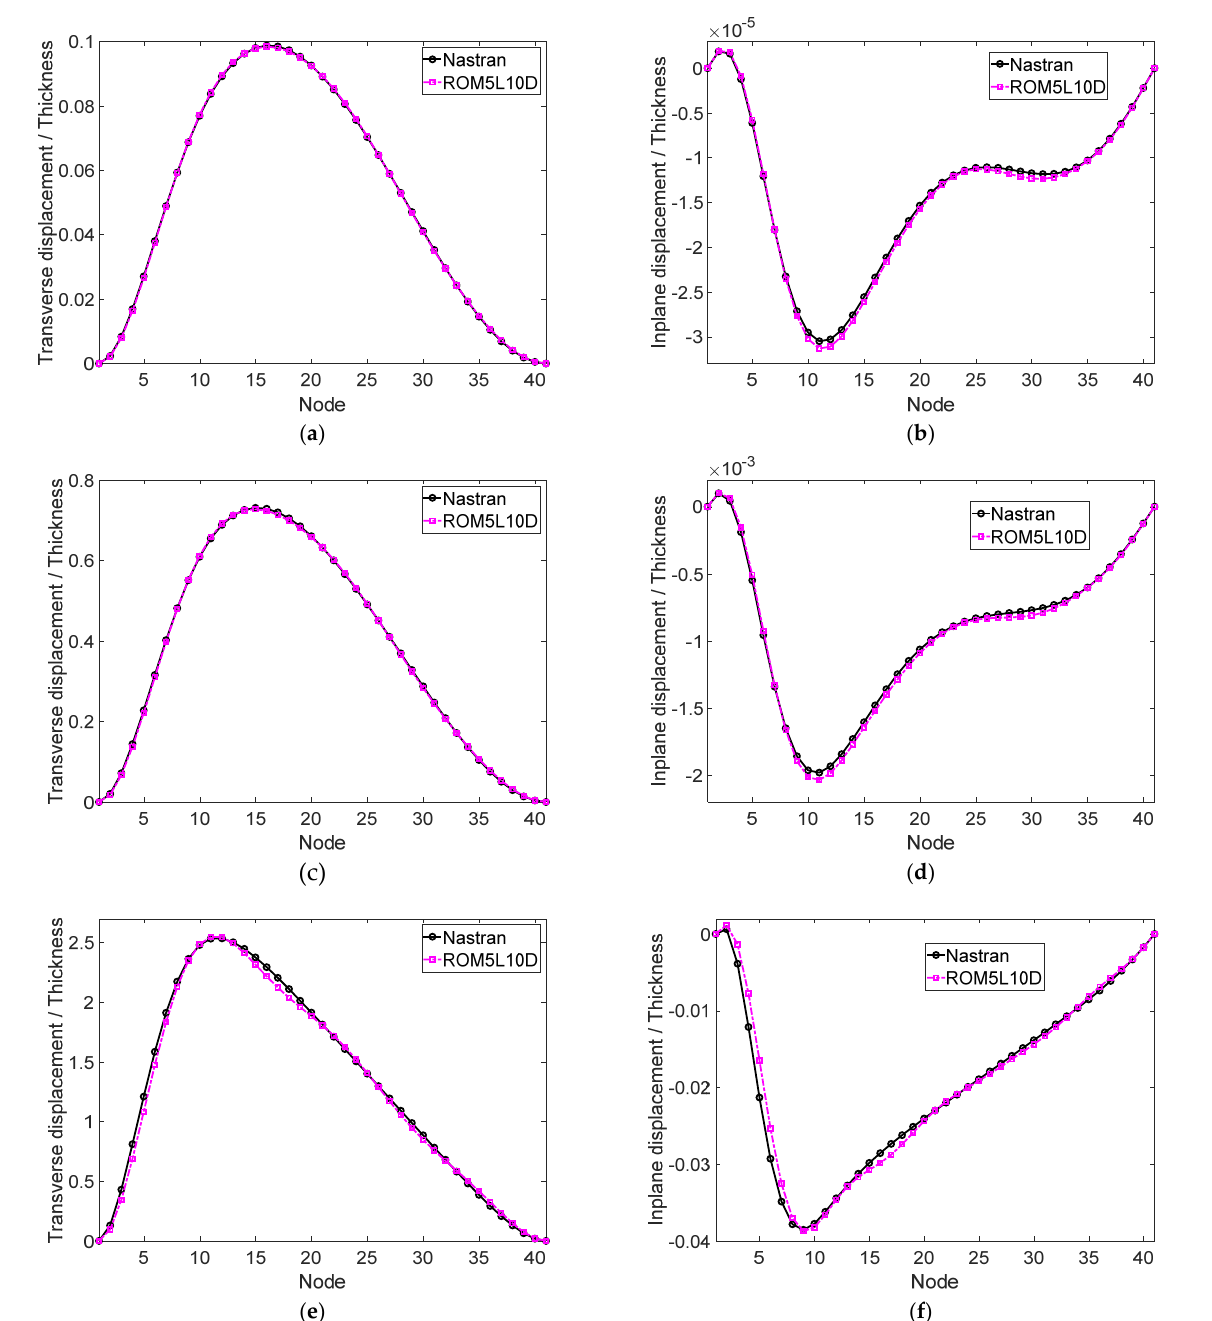
Figure 27. Static deformed shapes, clamped straight beam loaded on left quarter. Nastran and ROM predictions for different load levels. ( a , c , e ) Transverse displacements, ( b , d , f ) in-plane displacements.